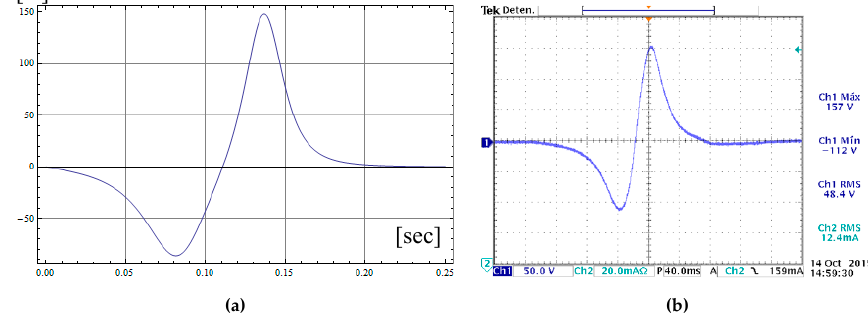
Figure 6. Pulse voltage generated by the inductive transducer: ( a ) theoretical case and ( b ) real case.